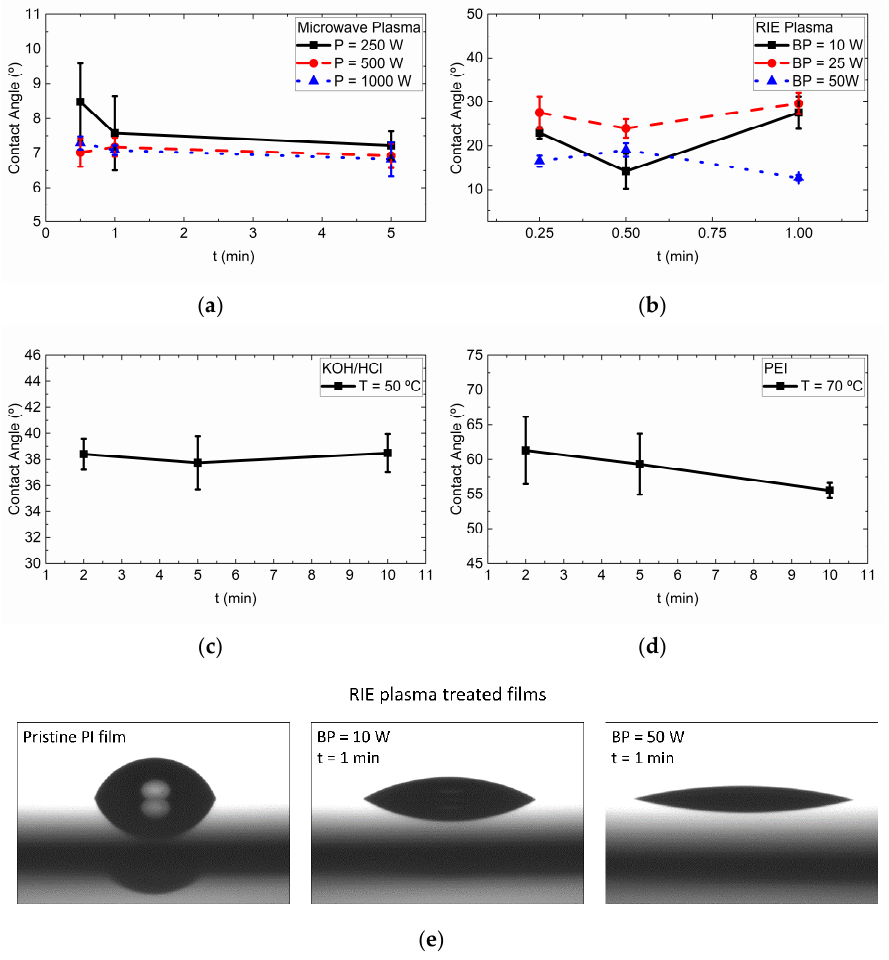
Figure 2. Water contact angle of treated PI films: ( a ) Microwave Plasma; ( b ) RIE Plasma; ( c ) KOH/HCl; ( d ) PEI solution; ( e ) Examples of water drops on RIE-plasma treated films.